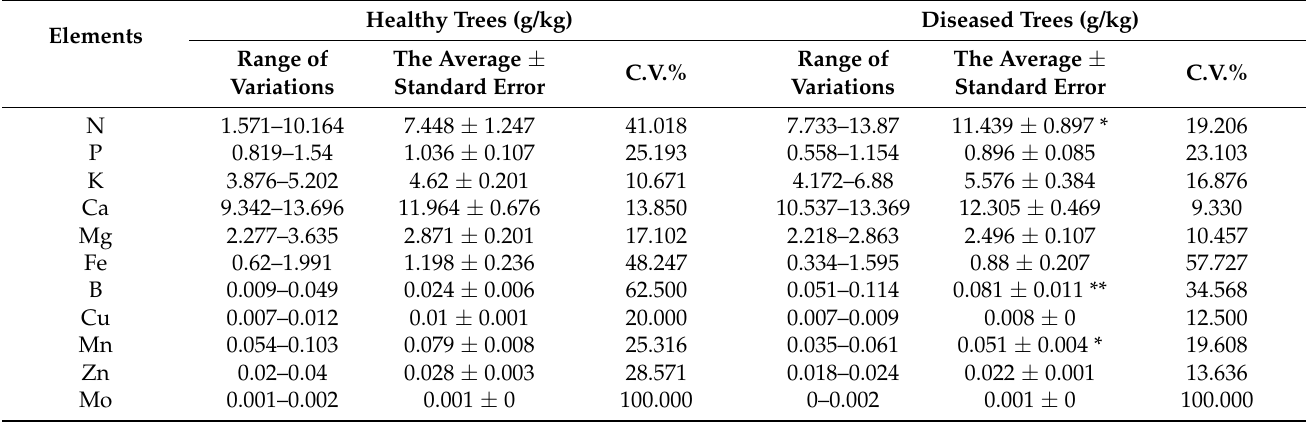
Table 2. Root nutrient elements in healthy and diseased chestnut trees.